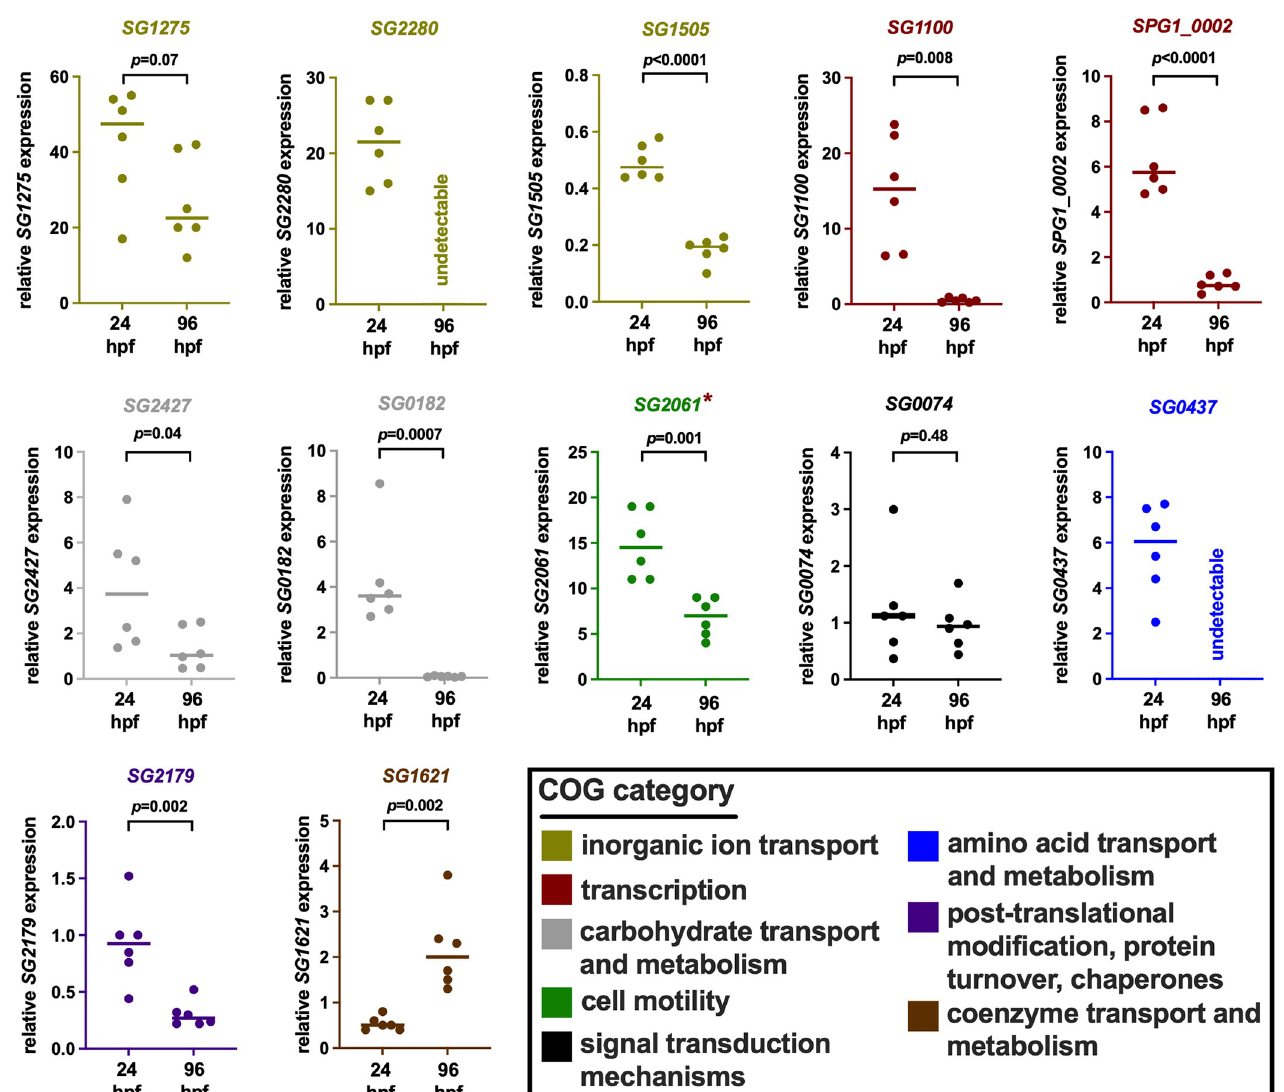
Fig 3. Relative expression of Sgm heme-regulated genes in vivo in tsetse’s midgut either 24 hr or 96 hr (high and low heme environments, respectively) after flies had received their last blood meal. Expression levels of each gene were quantified by RT-qPCR and normalized to Sgm’s constitutively expressed rplB gene. Individual dots represent one biological replicate, each containing three midguts. Sgm gene IDs and graph colors correspond to the COG category (shown in the box at bottom right) in which they each group. Sgm gene SG2061 is indicated by a cayenne asterisks because it also groups within the ‘transcription’ COG. Expression of SGP2_0009 was undetectable in Sgm that reside in tsetse’s midgut and thus left out of this figure. hpf, hours post-feeding. Bars represent median values, and statistical significance was determined via Student’s t-test (GraphPad Prism v.9.4.1).